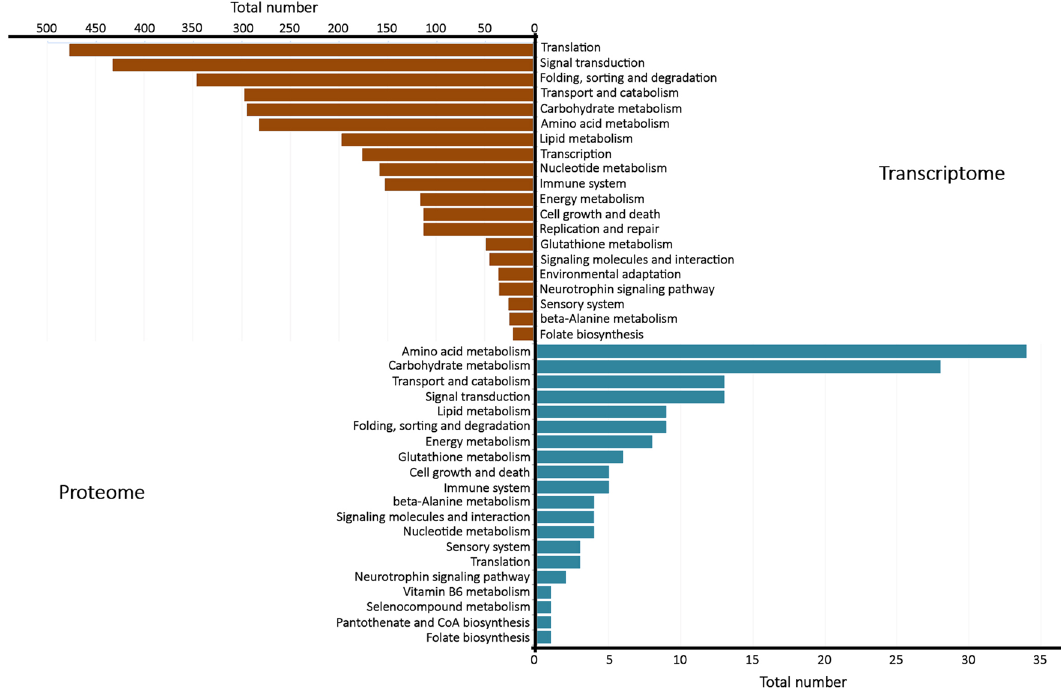
Figure 2. Enriched pathways. Top 20 enriched KEGG pathways among the annotated transcripts in the transcriptome and the proteome. The total number of transcripts were 5,022 and 251 for the transcriptome and the proteome, respectively. The pathways were grouped manually in more general terms. The figure was drawn using Microsoft Excel version 1.5 (www.micro soft.com/).